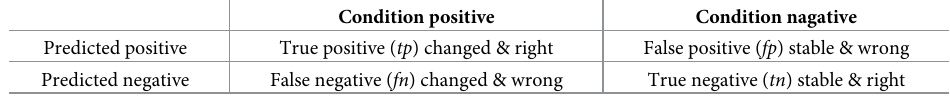
Table 5. The 2 × 2 contingency table for change in the leadership of a